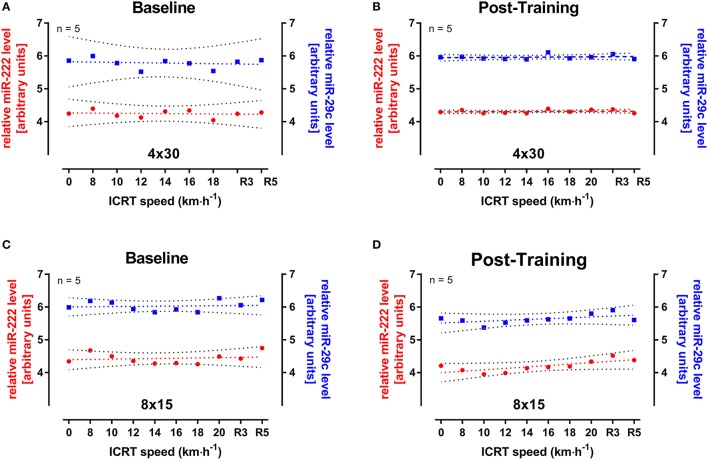
miR-222 and miR-29c levels during incremental continuous running test (ICRT) at baseline and follow-up. Five participants from either HIIT group were randomly selected and miRNA levels were determined during ICRT at (A,C) baseline and (B,D) follow-up. No significant change in miR-222 (red) or-29c (blue) levels was detected during ICRT or subsequent recovery (R3, R5). At follow-up, variation of miRNAs levels was reduced in the 4 × 30 HIIT group indicated by decreased widths of 95% CIs (gray) but not in the 8 × 15 HIIT group. Data are represented as mean with linear regression and 95% CI. R3, after 3 min of rest; R5, after 5 min of rest.